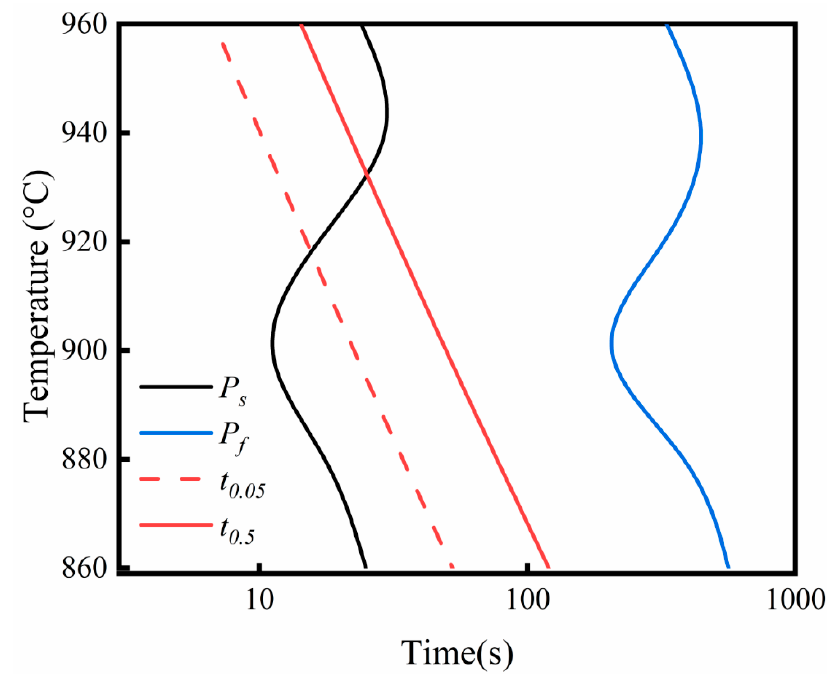
Figure 9. RPTT curve for Ti microalloyed steel .